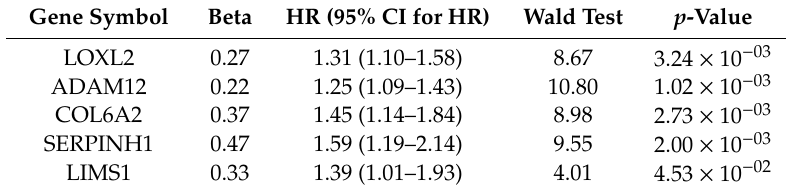
HR: hazard ratio; CI: confidence